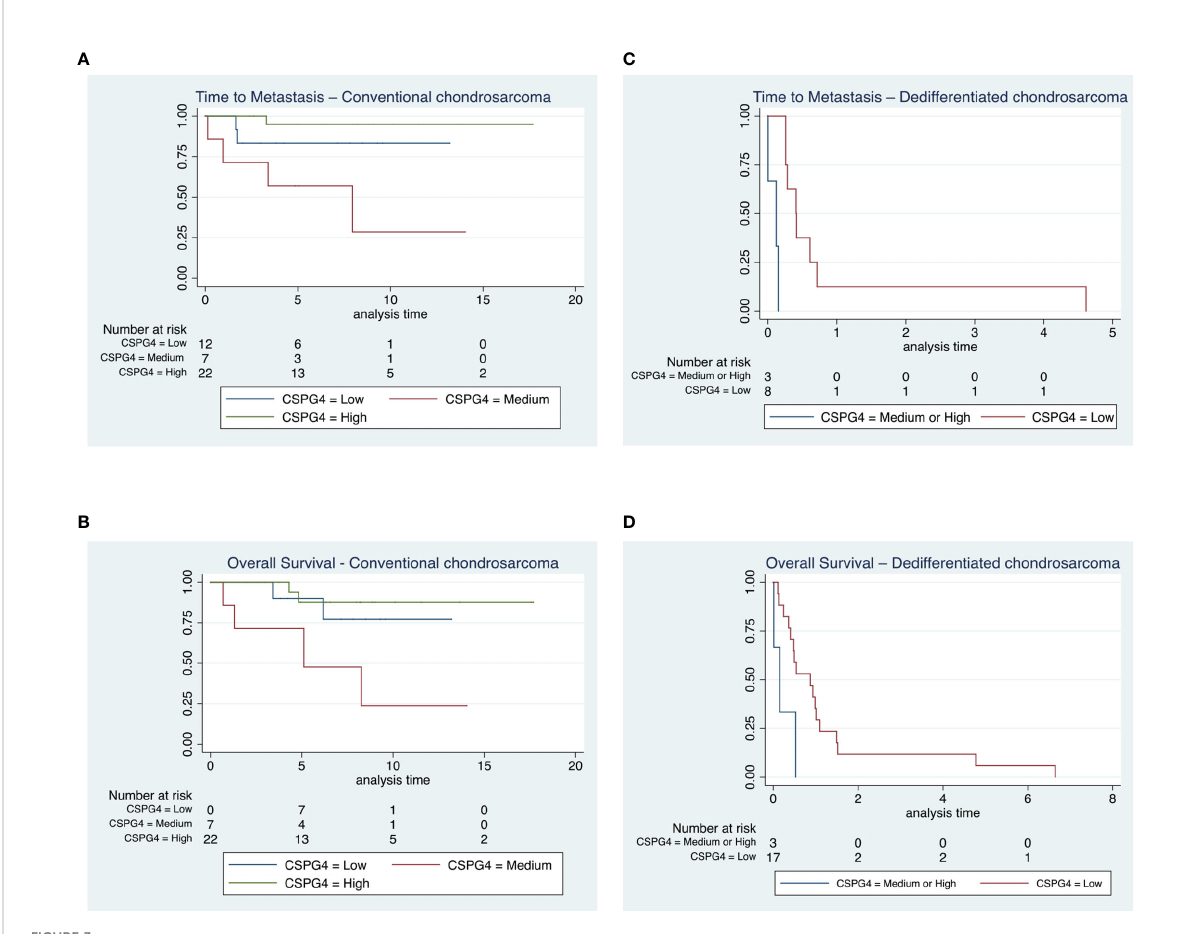
FIGURE 3 Time to metastasis and overall survival in conventional and dedifferentiated chondrosarcoma. (A, B) All patients diagnosed with chondrosarcoma grade 1 (n = 17) remained alive throughout the duration of the study, 7 out of the 30 subjects diagnosed with chondrosarcoma grade 2 and 2 out of 5 patients with chondrosarcoma grade 3 died from their disease. We observed a shorter time to metastasis in subjects with medium CSPG4 expression compared to the other groups in CSPG4 expression (p = 0.004) and there was a shorter time to death in subjects with a medium CSPG4 expression (p = 0.019). (C, D) All 24 patients with a dedifferentiated chondrosarcoma died from their disease. We observed a shorter time to metastasis in subjects who had medium and high CSPG4 expression when compared to subjects with low or no CSPG4 expression in chondrosarcoma (p = 0.048). In addition overall survival was shorter in subject who exhibited medium and high CSPG4 expression compared to subjects with low or no CSPG4 expression in chondrosarcoma tissues (p =